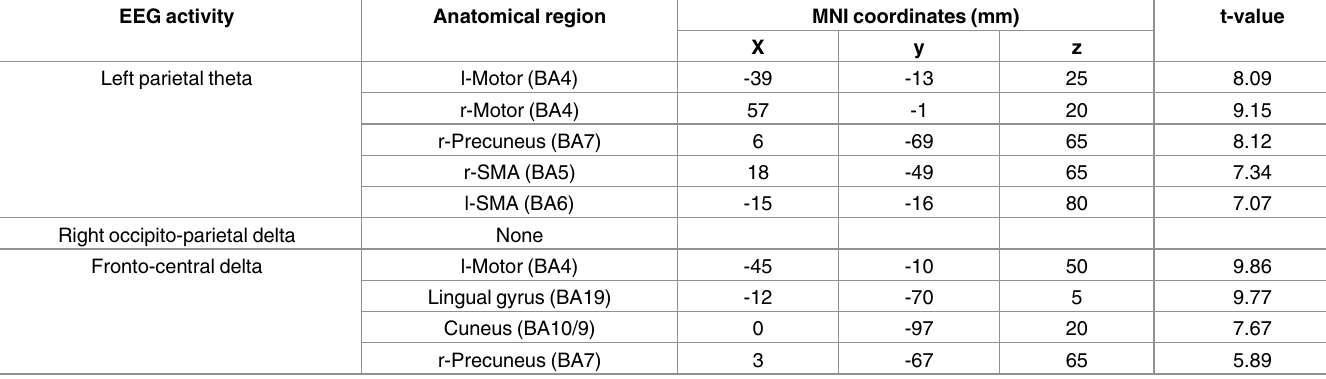
Table 1. Brain areasshowing correlations with EEG activities.